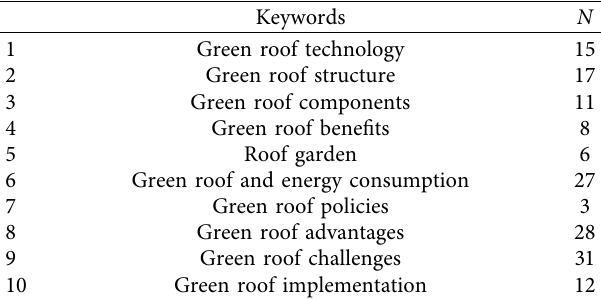
Table 2: Keywords of some research used in the current research in the field of green